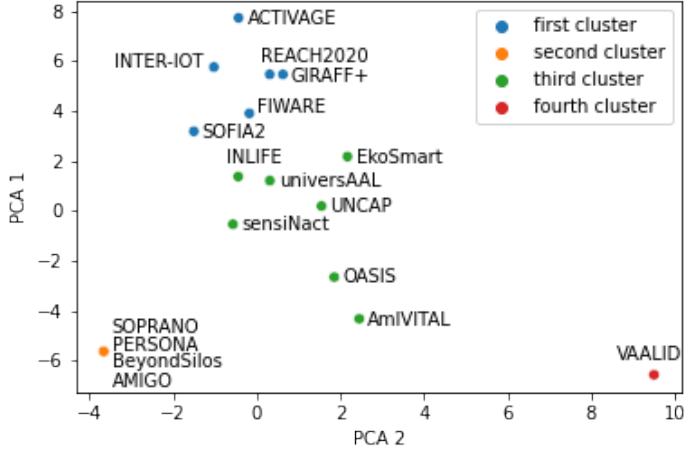
Figure 3. Result of k-means with four clusters and standardized input data.